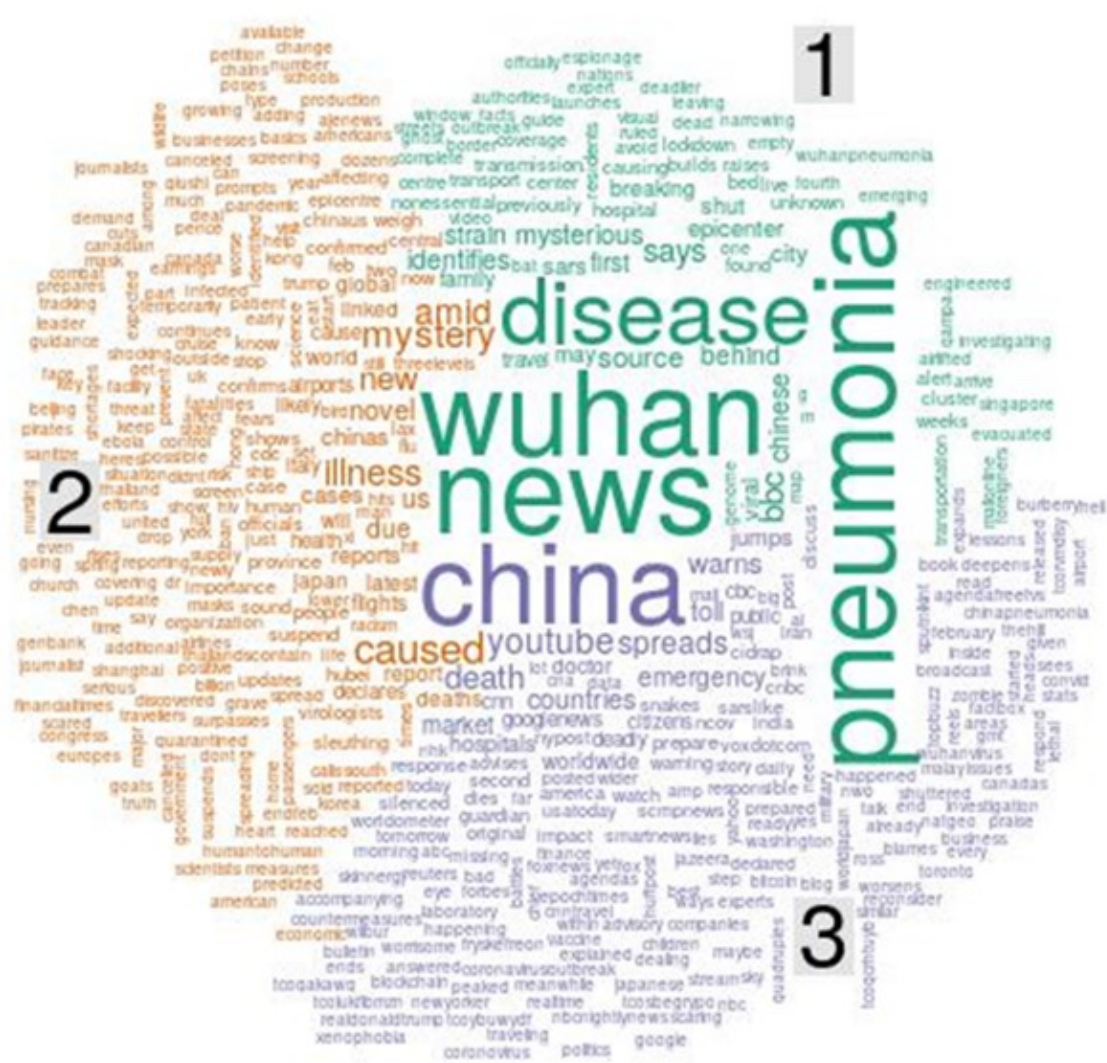
Figure 13. Word cloud and topic modeling of keywords related to the COVID-19 outbreak, organized into three topics: (1) The new strain of pneumonia identified in Wuhan, China; (2) the mysterious illness caused by the novel virus; (3) the warning from China that the death toll of COVID-19 could